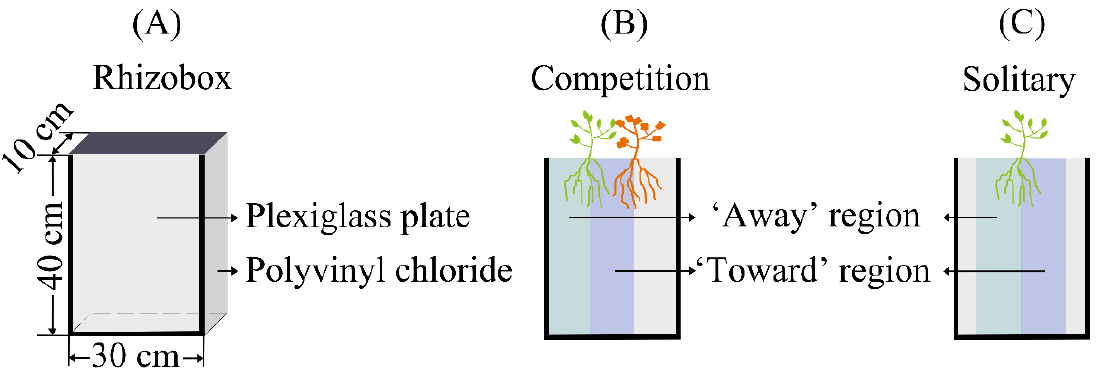
Figure 7. Schematic of heterogeneous nutrient treatments.